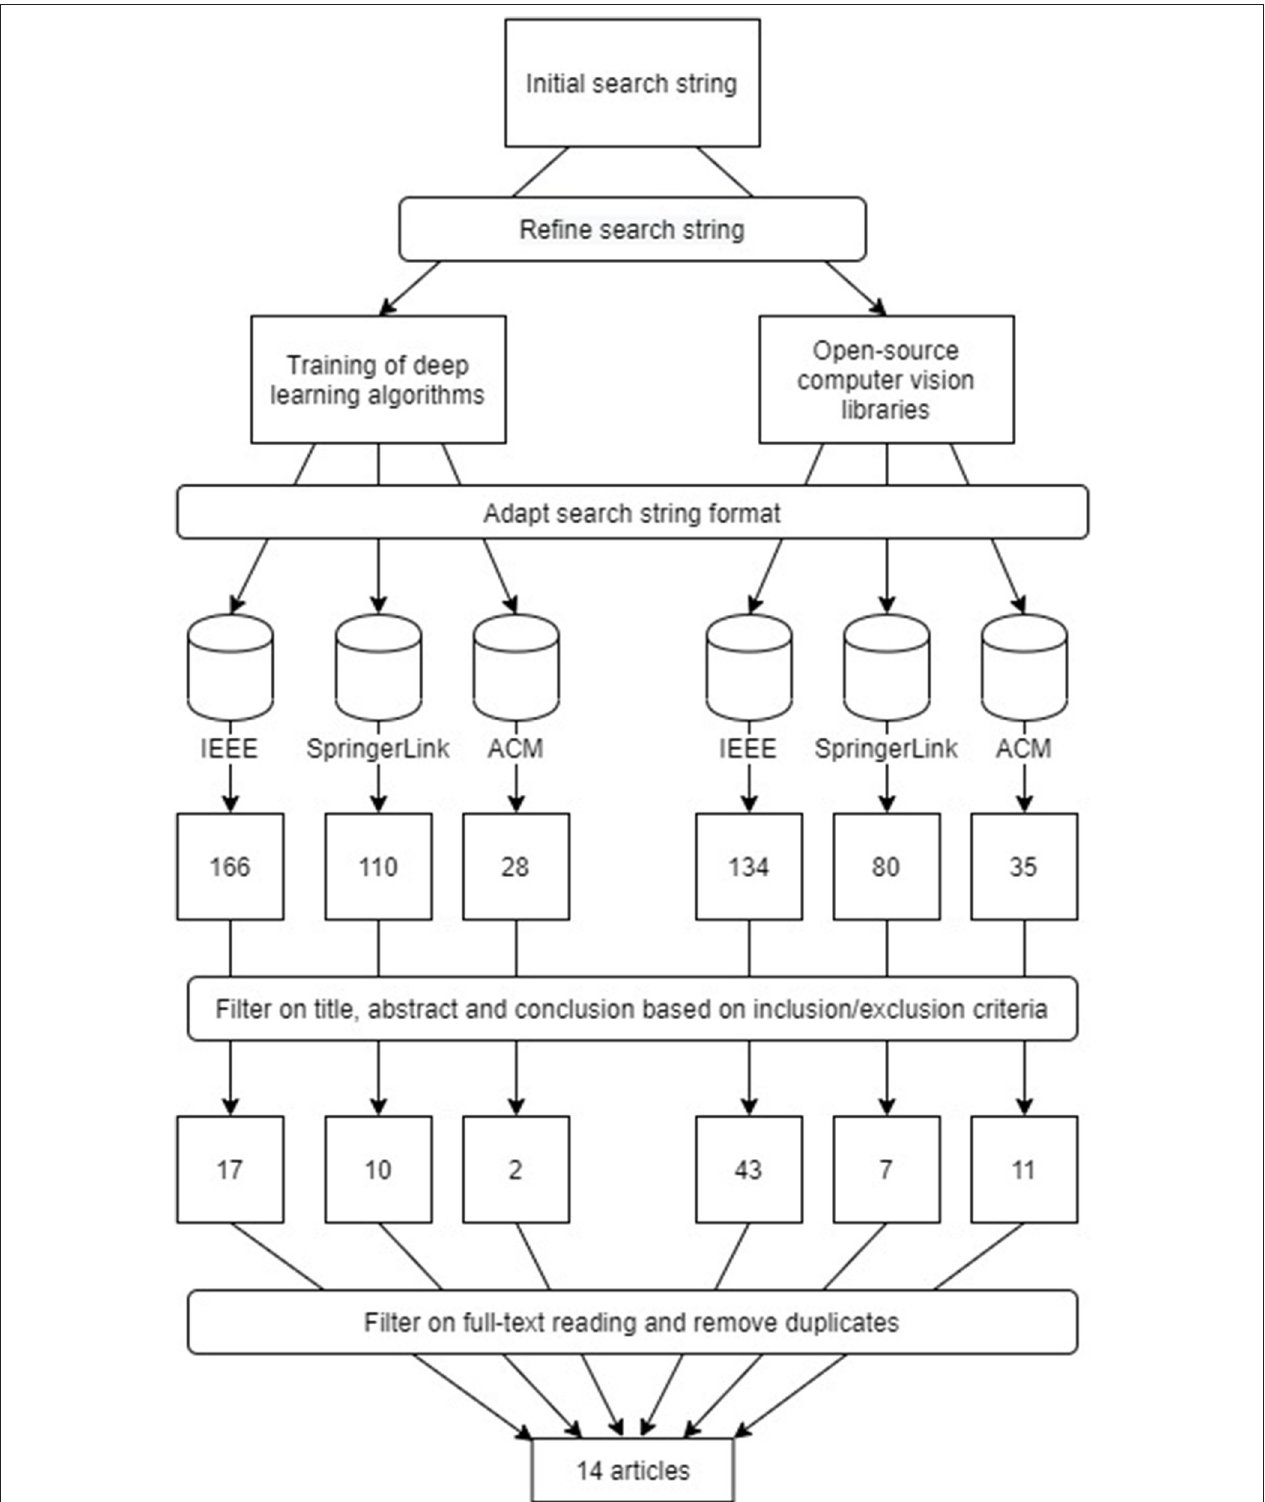
FIGURE 4 | Overview of filtering process and results from systematic literature review.